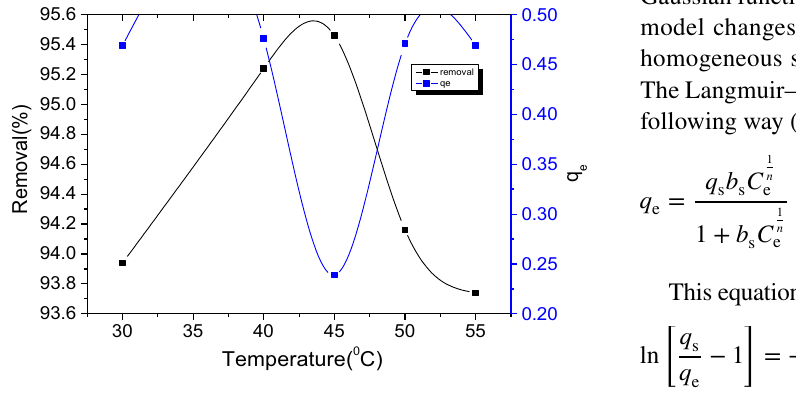
Fig. 9 Effect of temperature